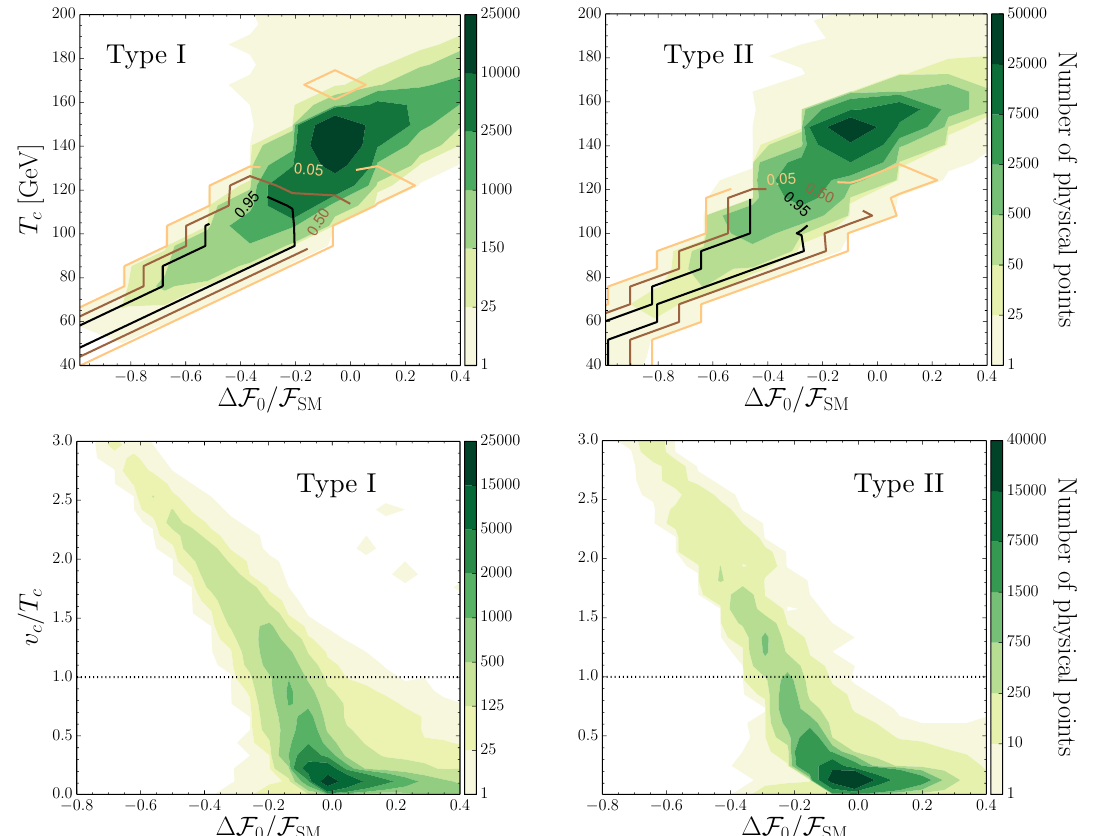
Figure 1 . Results of a numerical scan of the 2HDM parameter space (see text for details) showing the correlation between the (cid:1) and (top) the critical temperature (bottom) the strength of the F 0 EWPT for Type I (left) and Type II (right). Filled contours indicate the density of physical points. Also shown are contours of , the posterior probability of having a strong (cid:12)rst order P (cid:24)> 1